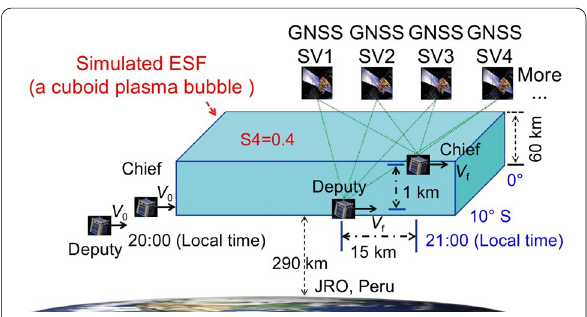
Fig. 12 An ESF observation scenario illustration. (Adapted from Peng et al. (2020))